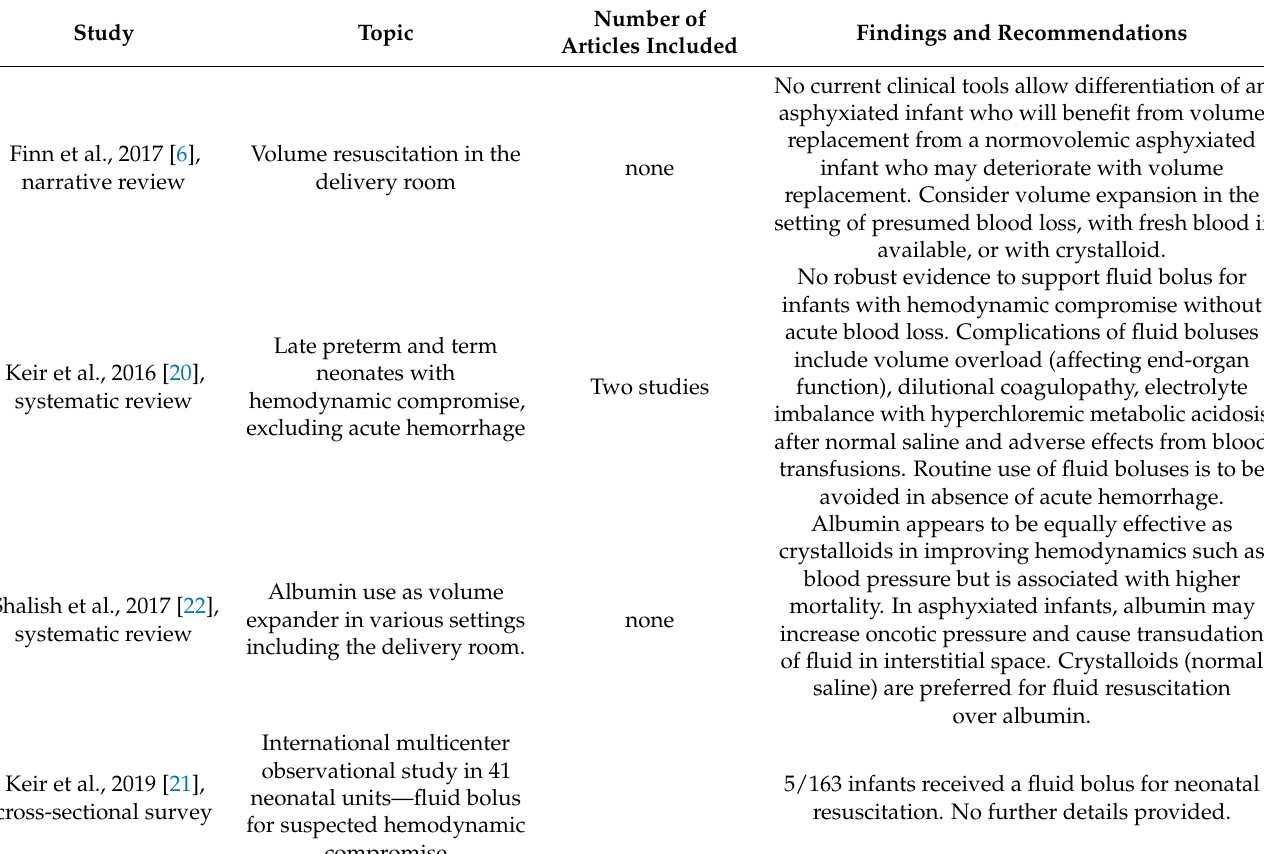
Table 2. Summary of selected narrative and systematic reviews and observational studies evaluating volume replacement during neonatal